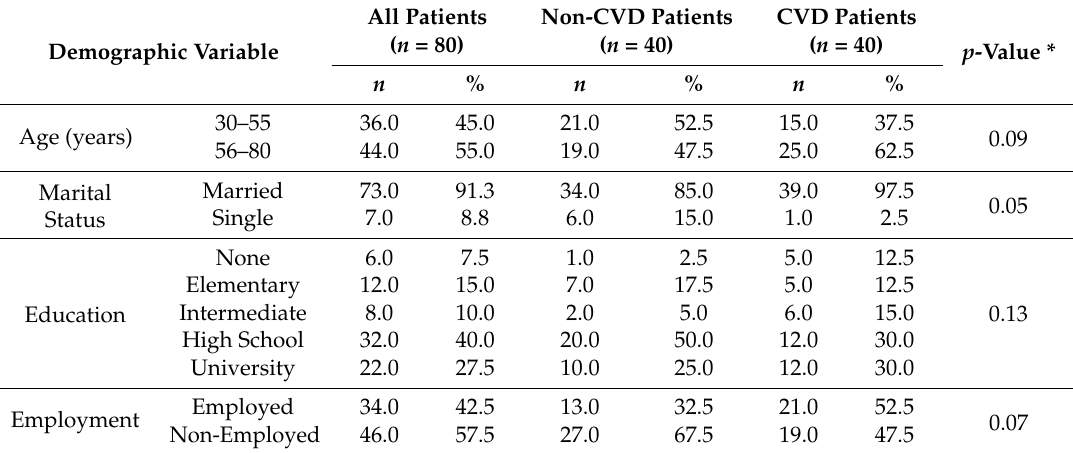
Table 2. Demographic data of the study participants.